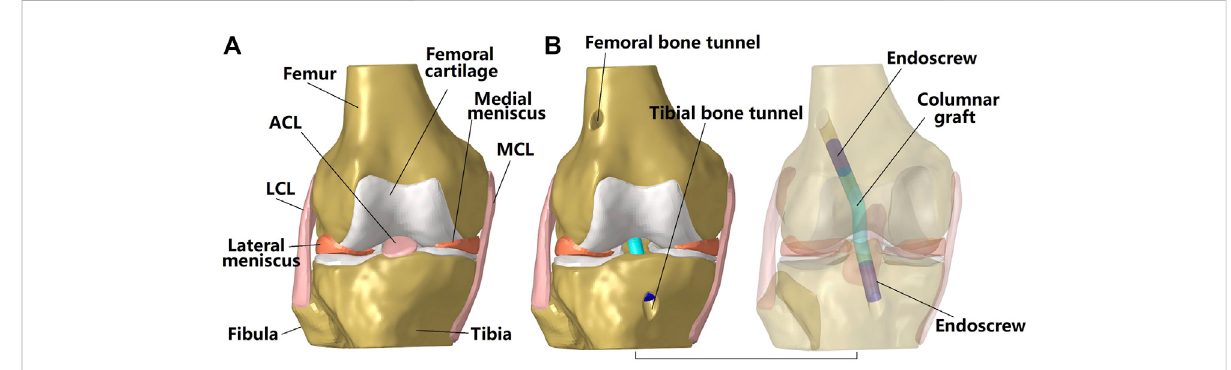
FIGURE 1 Threedimensionalmodel ofacadaveric knee. (A) Intact knee; (B) Knee after ACLreconstructionusing acolumnar graft. The transparent model shows the fi xation ofthegraftto thebonetunnel usingan endoscrew. Oneend oftheendoscrew wastiedwiththegraft while theoutside surfaceof the screw was tied with the inside wall of the bone tunnel. LCL, lateral collateral ligament; MCL, medial collateral